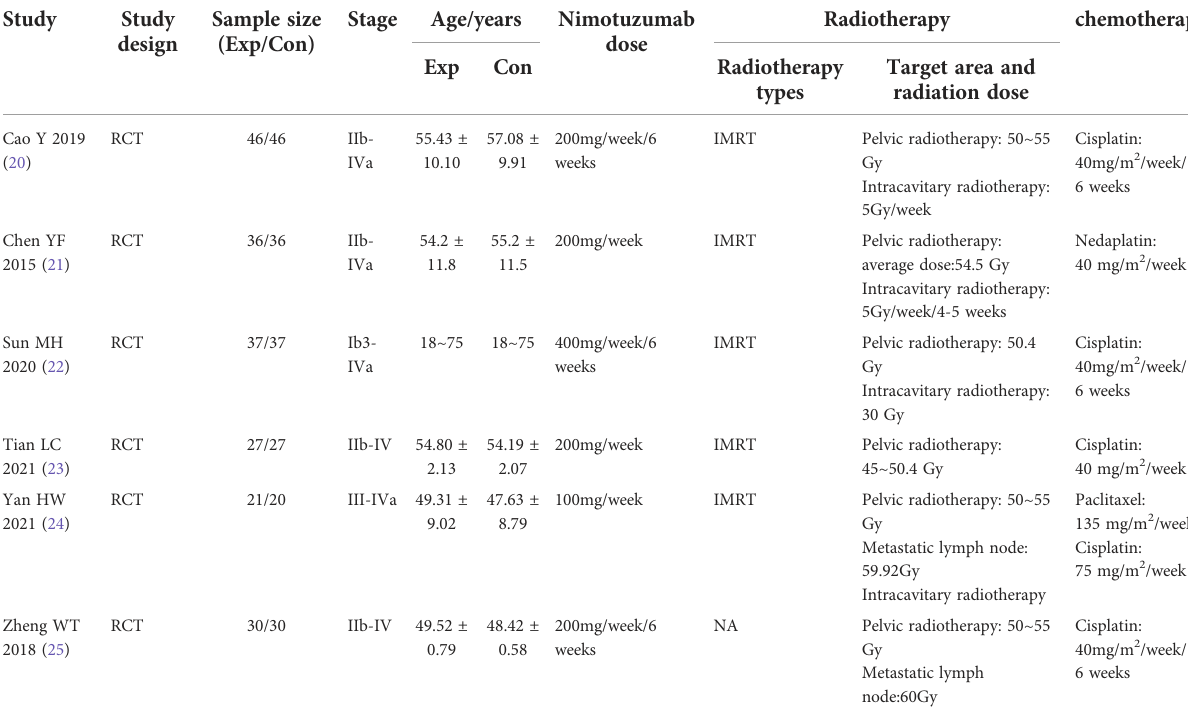
TABLE 1 Characteristics of studies